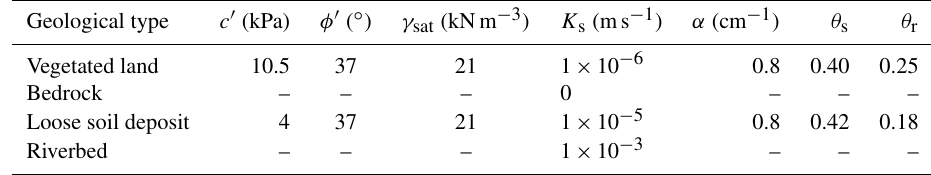
Table 2. Properties of four types of superficial materials.